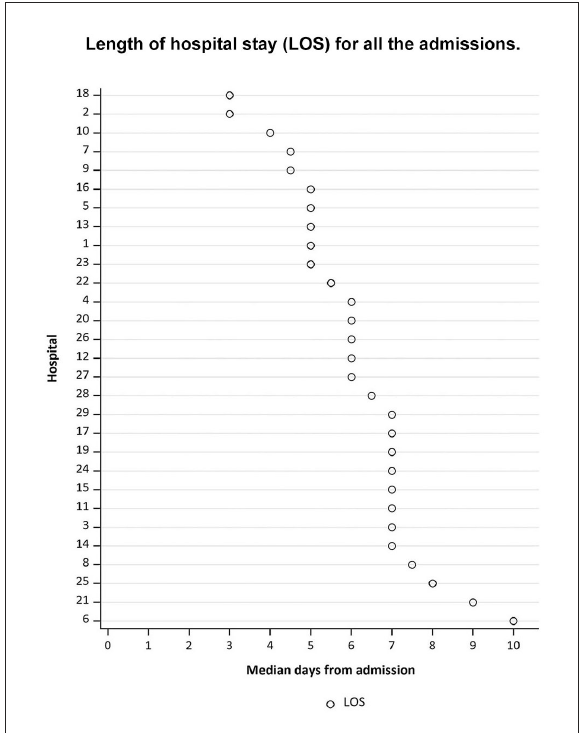
FIGURE3 The hospitals’ randomization numbers are plotted in the y-axis, sorted from long LOS at the top of the figure, to short LOS at the bottom of the figure. The median days from admission are plotted in the